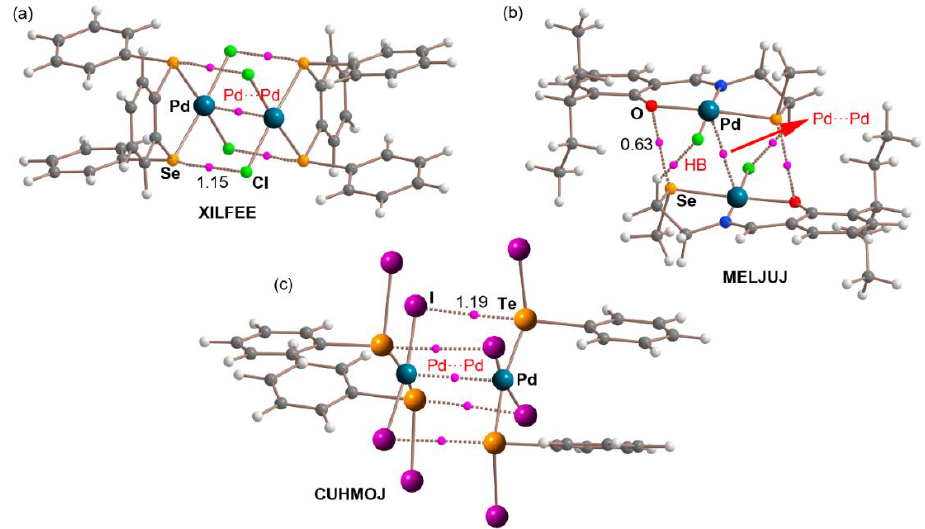
Figure 16. Distribution of intermolecular bond CPs (colored in pink)and bond paths regarding XILFEE ( a ), MELJUJ ( b ) and CUHMOJ ( c ) dimers. The value of the density at the bond CP is given in a.u. (ρ·100). Pd···Pd and anci llary HB interactions are highlighted in